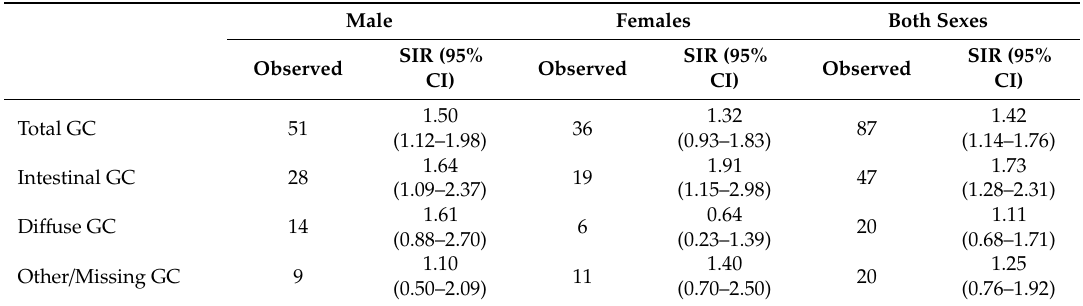
Table 3. Standardized incidence ratios (SIR) for subtypes of gastric cancer of resettlers compared to the general Münster population.